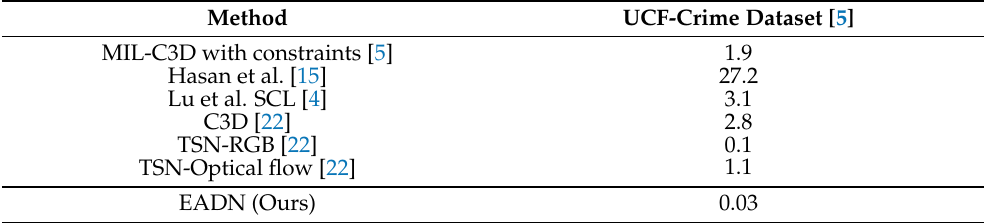
Table 6. False alarm rate of the proposed EADN framework against state-of-the-art methods. In addi- tion to the UCF-Crime dataset, EADN gives 0.08, 0.06, and 0.04 false alarm rates on the UCSDped1, UCSDped2, and the CUHK Avenue datasets.